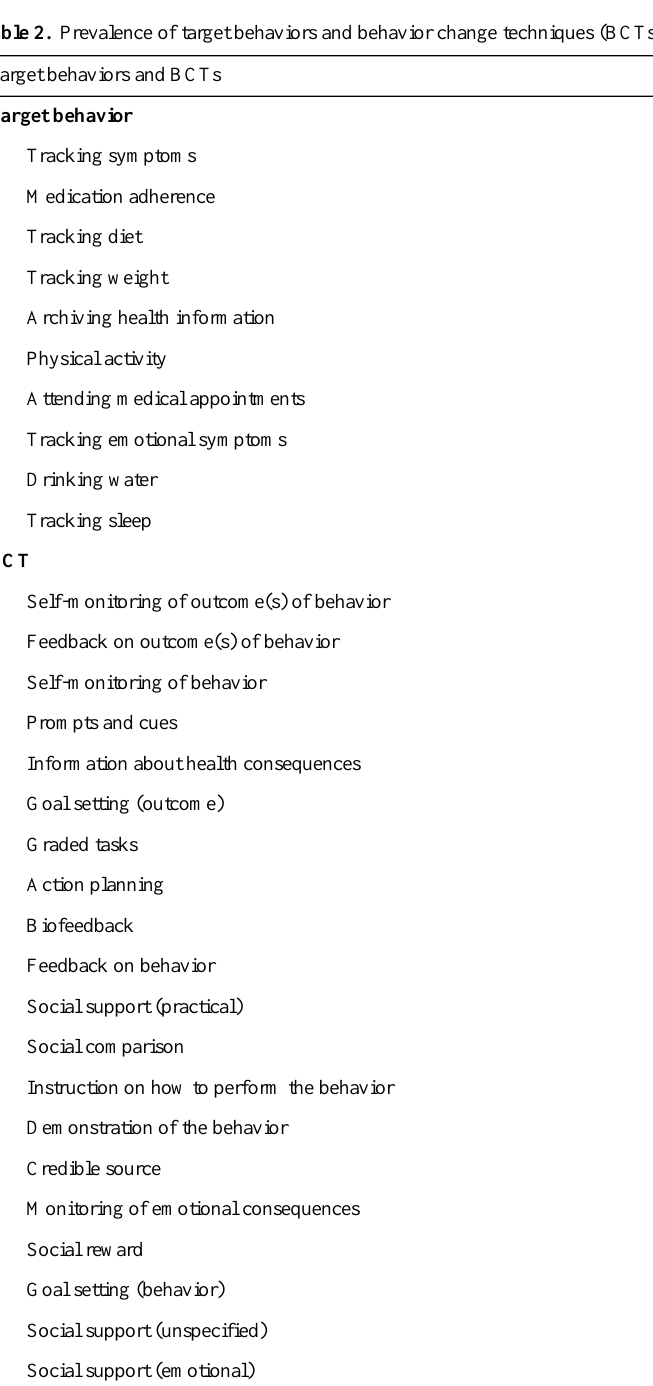
Table 2. Prevalence of target behaviors and behavior change techniques (BCTs) in the app sample.